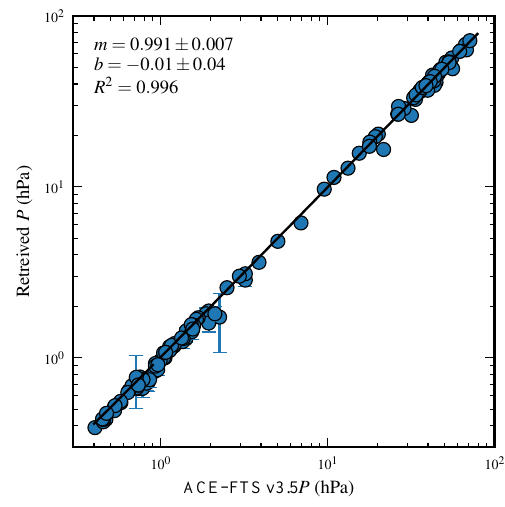
Figure 3. Correlation between retrieved pressure at the P a level be- tween this work ( y axis) and ACE-FTS v3.5 ( x axis) for 124 ACE- FTS occultations. The range of P values corresponds to the range of altitudes chosen by the retrieval algorithm to be the P a level. Error bars are uncertainty in retrieved P a